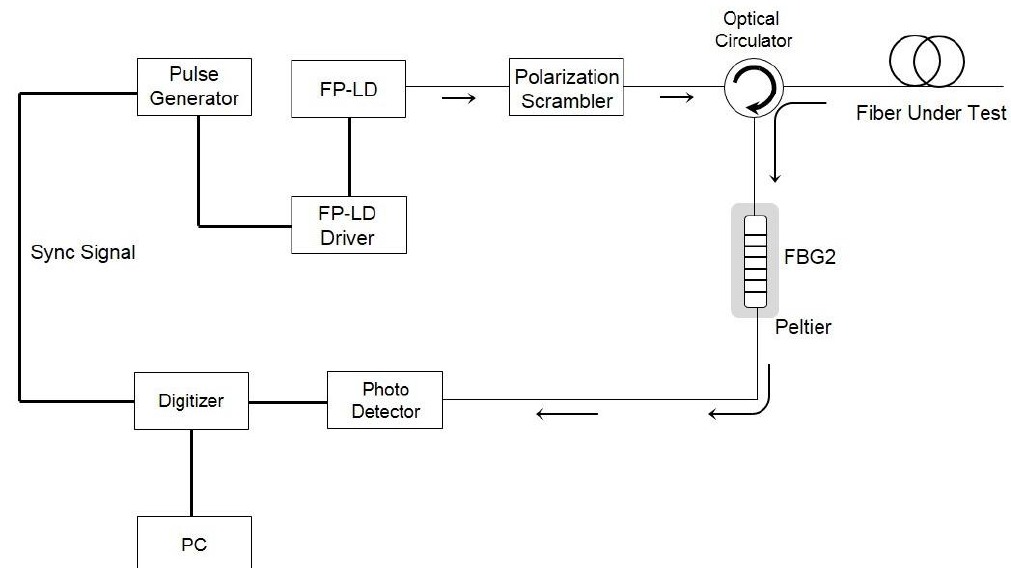
Figure 2. Schematic diagram of Rayleigh